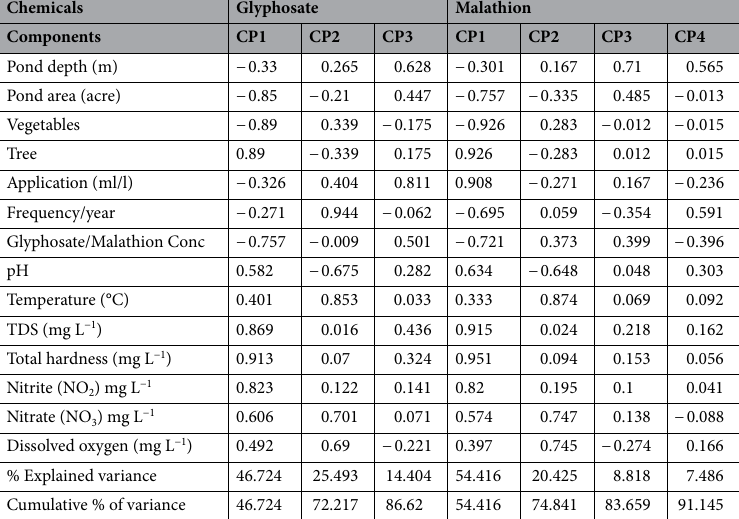
Table 1. Component matrix for different physicochemical parameters of fish farm water with glyphosate and malathion. PC = Principal component. Strong loading values ≥ 0.75, moderate loading values (0.5–0.75) and weak loading values